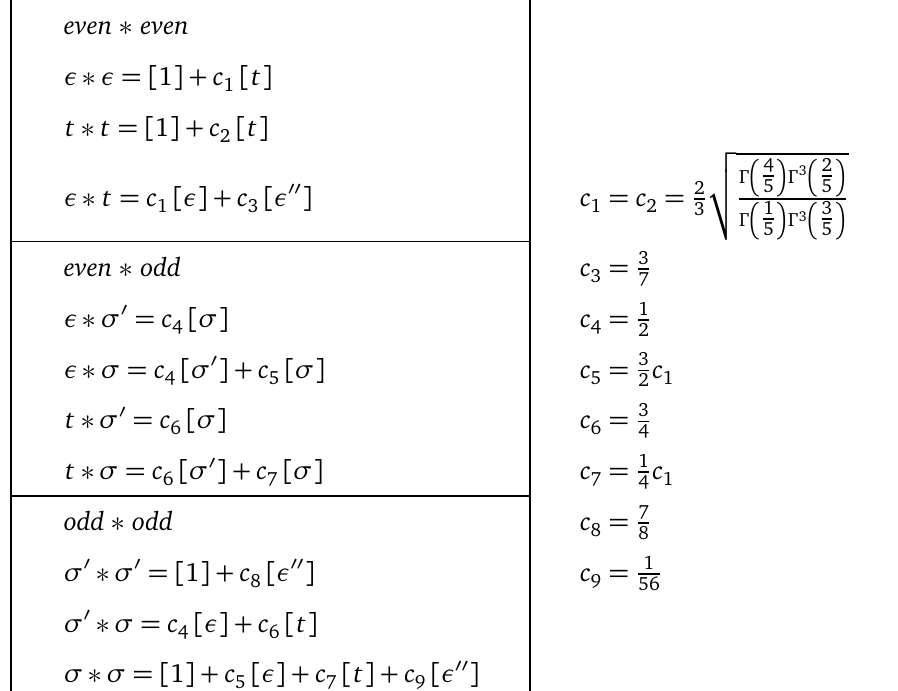
Table 3.3: OPE and structure constants of primary fields in the